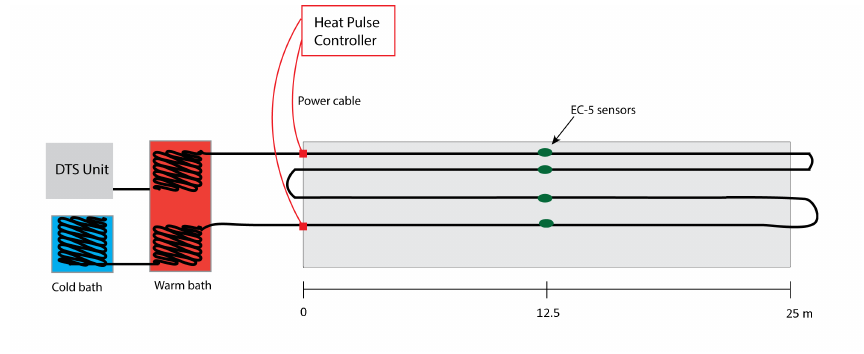
Figure 2. An illustrative diagram of the experiment